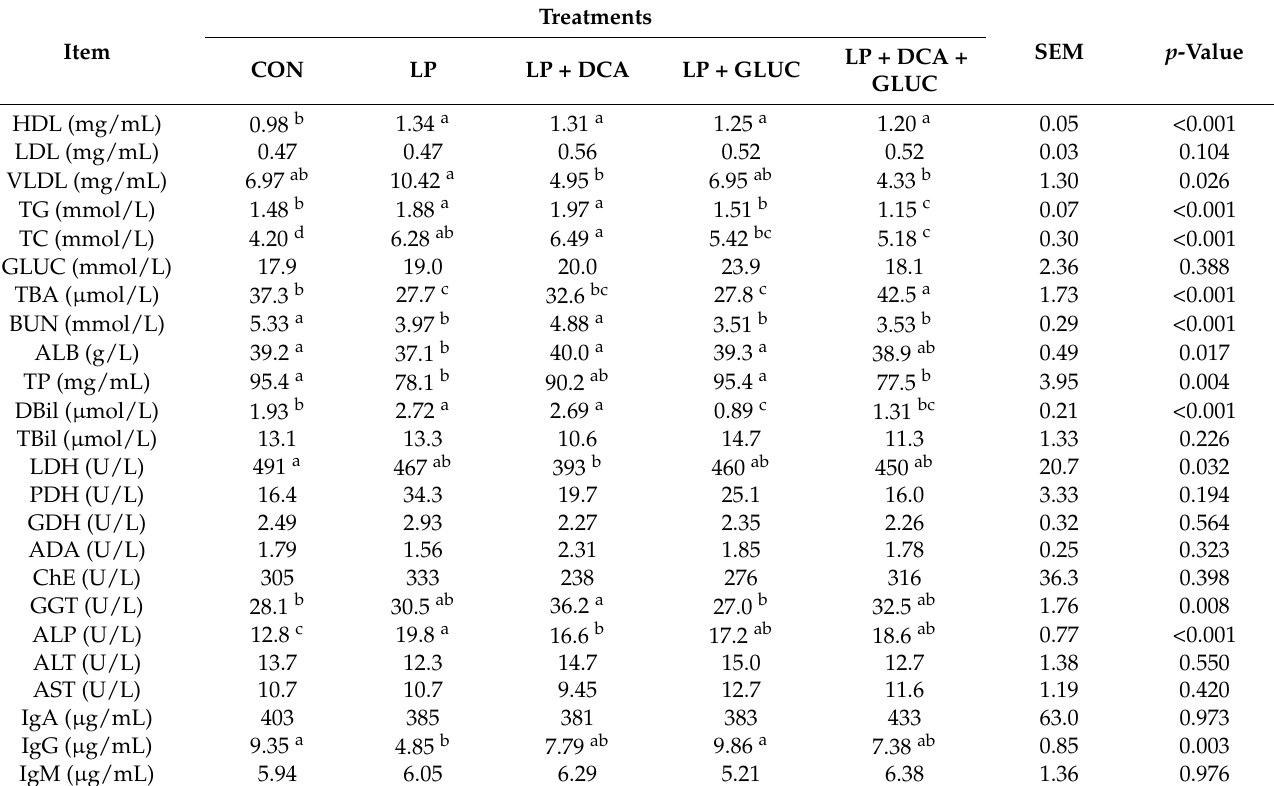
Table 1. Effects of supplementing low protein (LP) diets with sodium dichloroacetate (DCA) and glucose (GLUC) on the plasma metabolic and immunological biomarkers of growing-finishing